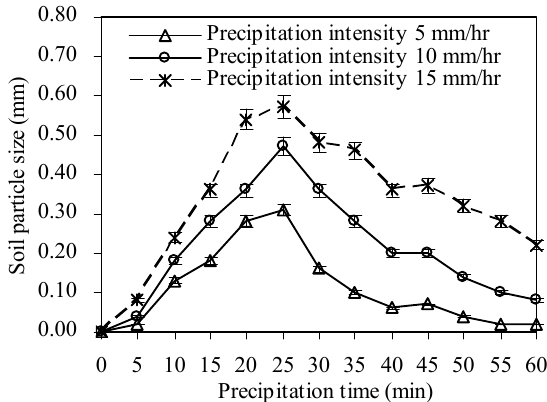
Figure 12. Variation in the particle size of eroded soils with the rainfall duration and intensity.